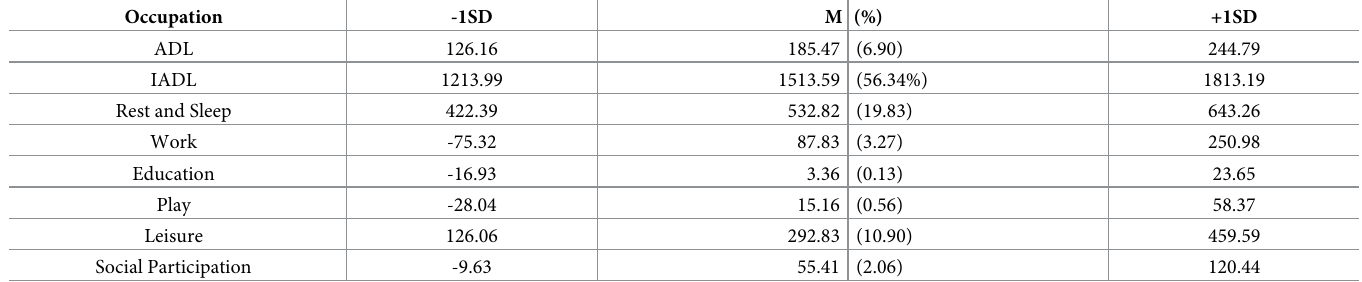
Table 1. Time-use of occupations